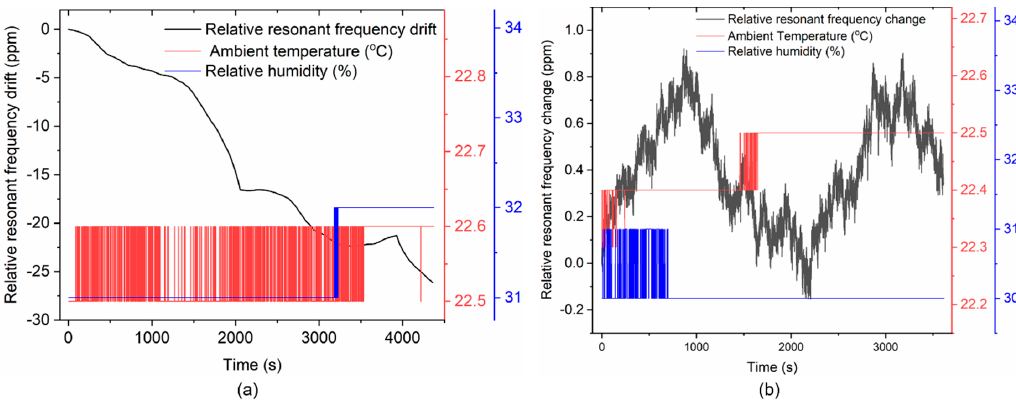
Figure 15. Relative resonant frequency drift (black line) of bare, silicon triangular cantilevers ( a ) TCant1 ( f 0 ≈ 181.265 kHz) and ( b ) TCant2 ( f 0 ≈ 262.253 kHz) under typical ambient temperature (red line) and relative humidity (blue line) conditions in the laboratory over measurement time ( ∼ 1 h).